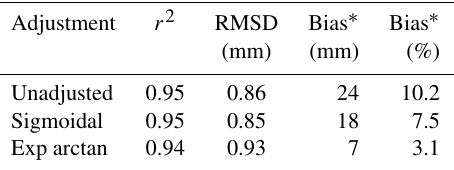
Table 2. Summary statistics for the comparison of the unadjusted and adjusted (sigmoidal and exponential-arctan functions) gauge snowfall measurements with the geolysimeter. Bias is the total gauge precipitation subtracted from (mm) or divided by (%) the total geolysimeter precipitation. Note that the adjustment was per- formed only on 51 of the 56 snowfall events due to some missing meteorological data; hence, the % bias is slightly different from that reported for all snowfall events in Table